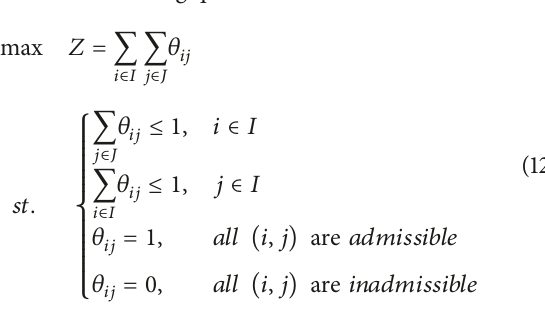
However, failure SDT may lead to unbalanced loads, including overcrowding or empty, or bus bunching. There- fore, an experienced operator should be performed very carefully with the help of the DF diagram. See the study by Ceder (2002) for details